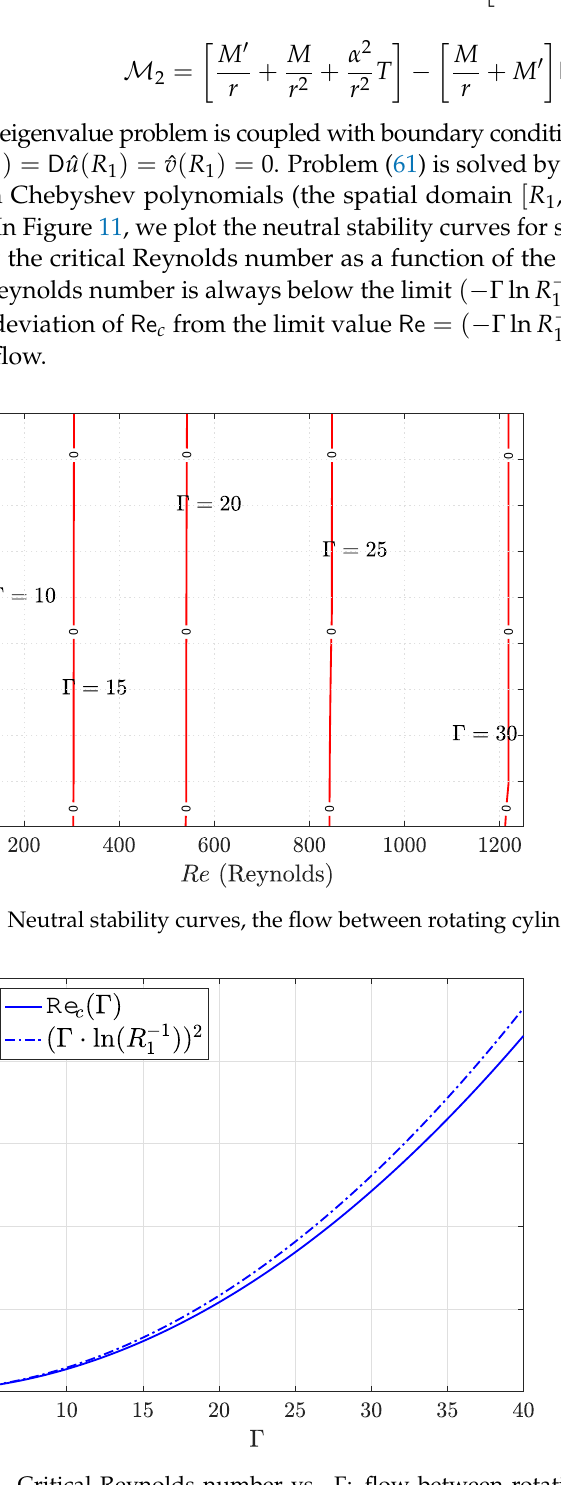
Figure 12. Critical Reynolds number vs. Γ : flow between rotating cylinders. Notice again the discrepancy between Re c and the upper bound as Γ